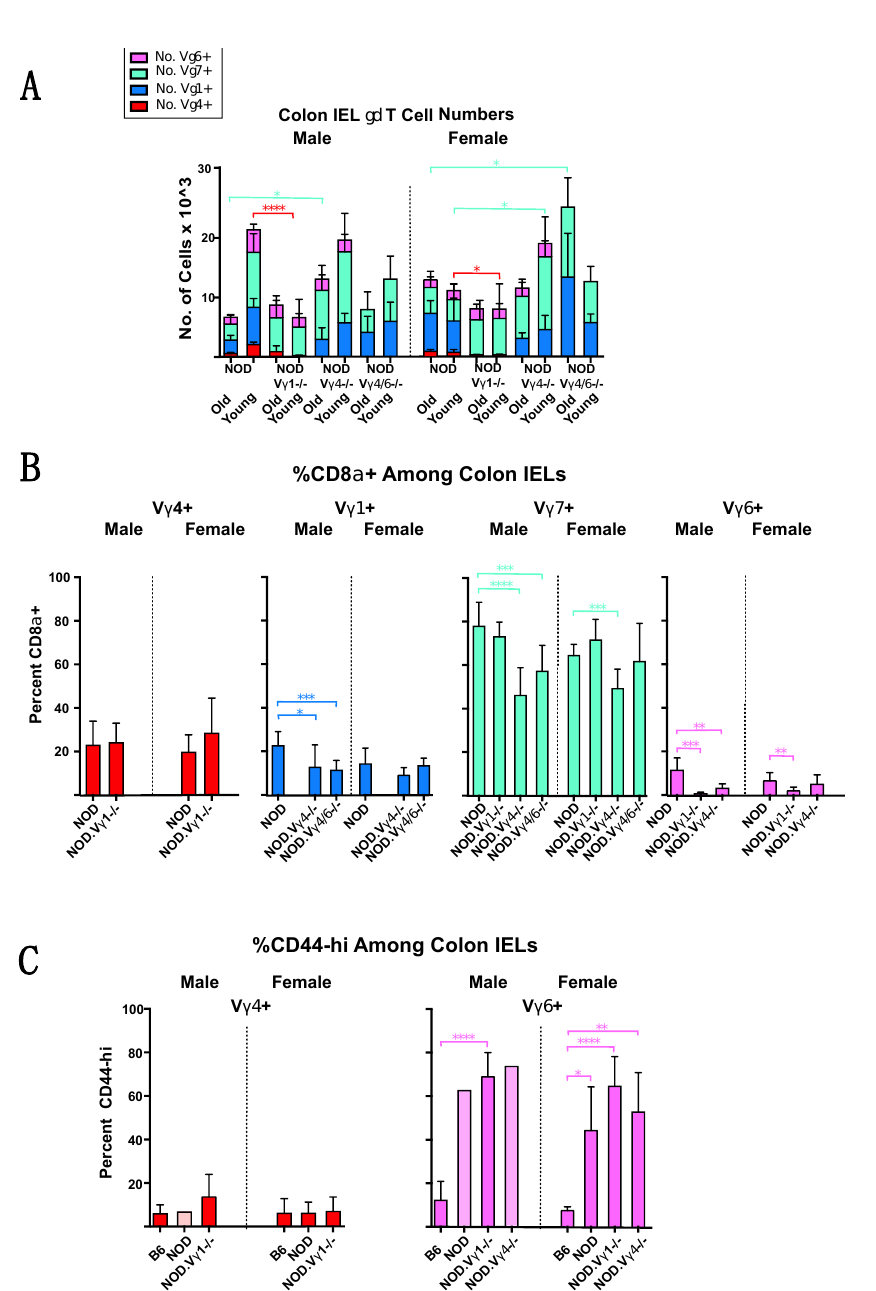
Figure 9. The γδ cells remaining in NOD-background γδ T cell subset-deficient vs. wt NOD mice among colon IELs. For ( A – C ), samples from 3–14 individual mice were analyzed per group, except in C where only a single male NOD and a single male NOD.V γ 4-/- mouse were available for the analysis. ( A ). The average number of cells obtained for each V γ -defined γδ T cell subset, in colon IELs. ( B ). The mean percentage of CD8 α + cells in four V γ -defined γδ T cell subsets, among colon IELs. ( C ). Mean percentages of colon V γ 4+ IELs (left) and colon V γ 6+ IELs that express high levels of CD44. Bars in a lighter hue denote data from a single mouse, and are shown for comparison. * p < 0.05, ** p < 0.01, *** p < 0.001, and **** p < 0.0001.